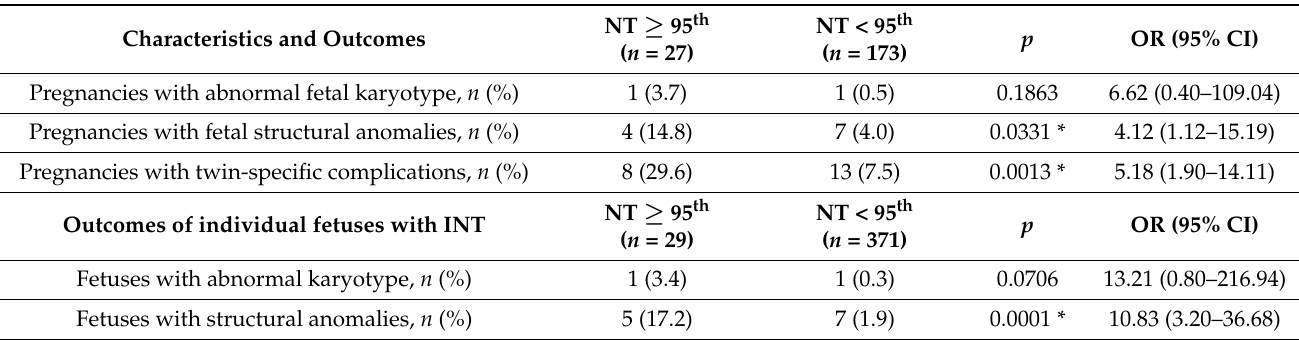
Table 5. Comparison of pregnancy outcomes in mc twin pregnancies and individual fetuses between increased NT ≥ 95 th and normal NT. ( n = 200).